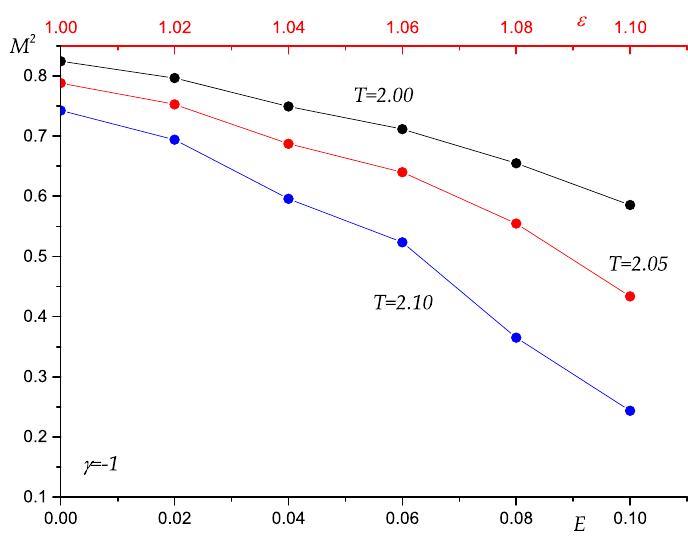
Figure 4. M 2 versus E at different temperatures ( A =